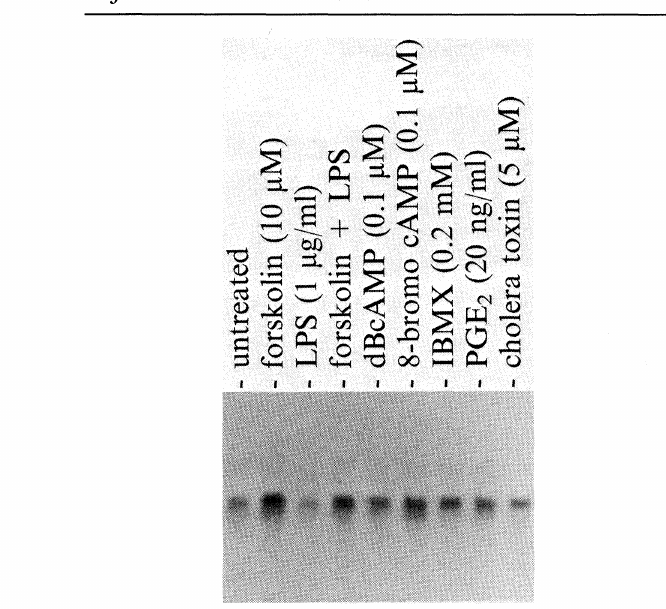
FIG. 4. Comparison of effects of agents which elevate cAMP on PDGF B chain mRNA expression and protein production. ANA-1 cells were cultured for 4 h with or without the following agents: forskolin (IOIM), LPS (1 lg/ml), dBcAMP (0.1 IM), 8-bromo- cAMP (0.1 IM), IBMX (0.2mM), PGE2 (20ng/ml), and cholera toxin (51M). Northern blot analysis reveals that a variety of agents which induce the accumulation of cAMP trigger the expression of PDGF B chain mRNA.